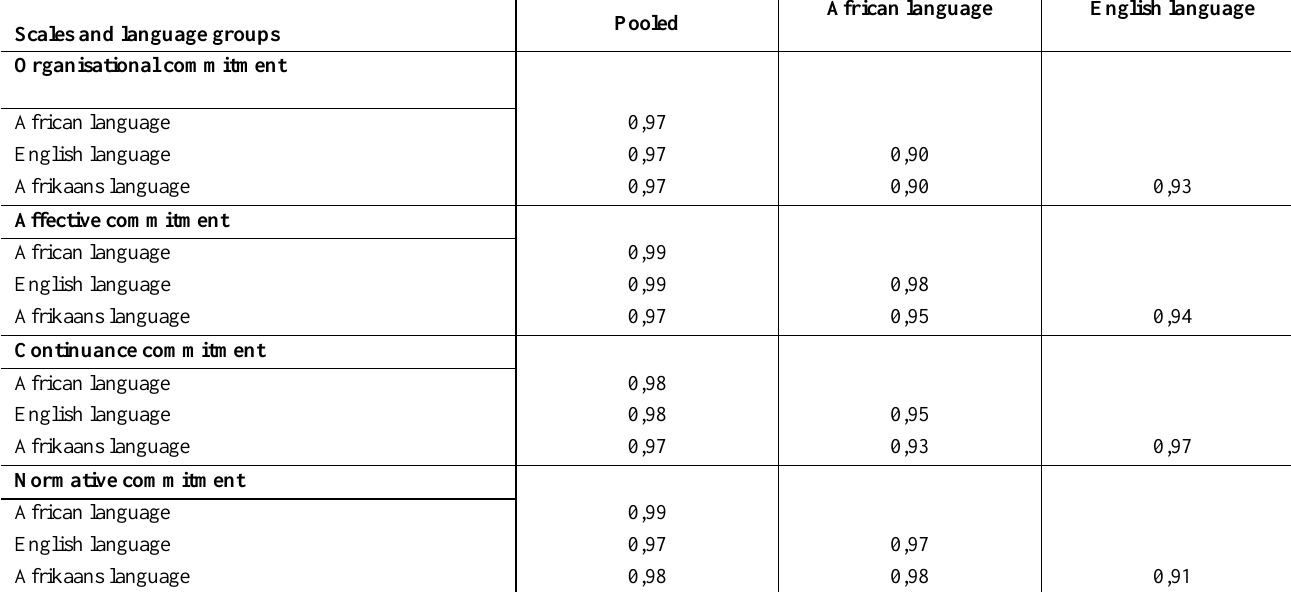
Table 2: Coefficients of congruence across language groups Scales and language groups